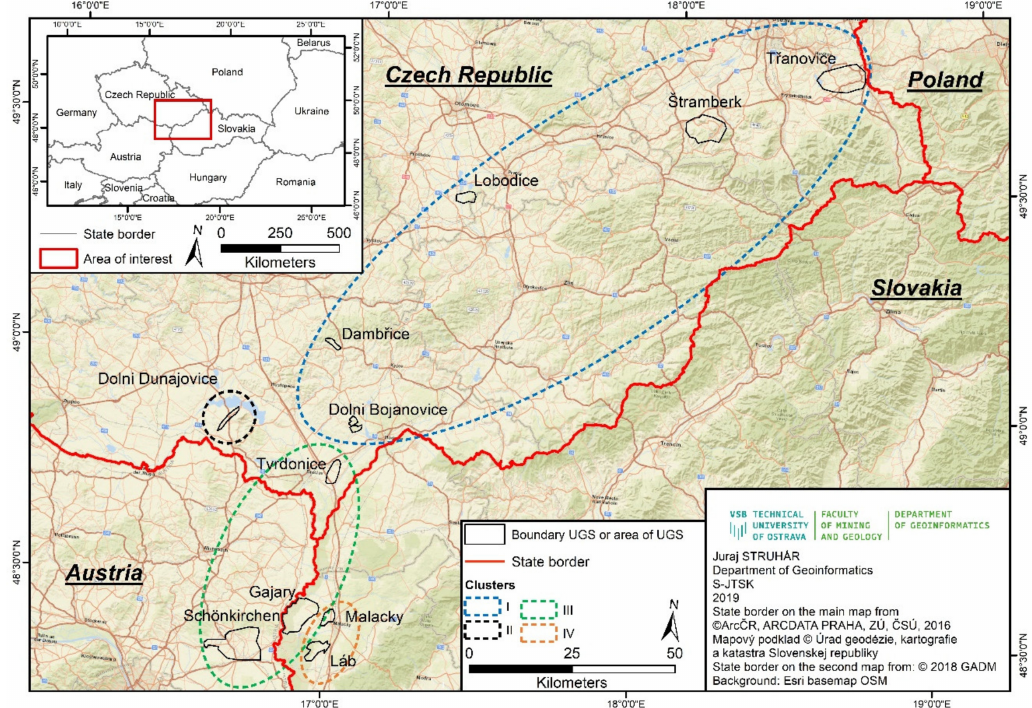
Figure 6. Distribution of the UGSs in the studied area (ellipses I, II, III, and IV show the distribution of UGS clusters from Figure